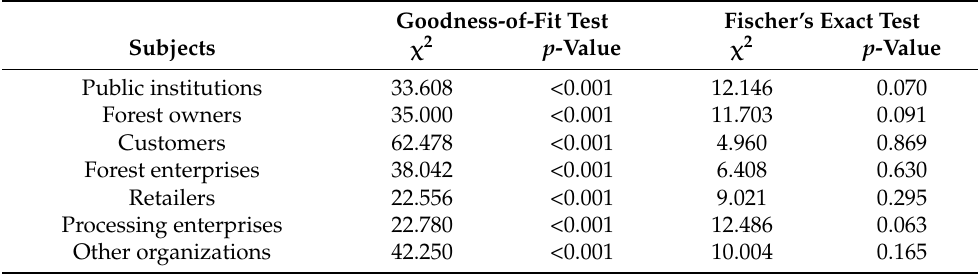
Table 5. Respondents’ perceptions of the effectiveness of their promotional activities with reference to the subjects to whom these were addressed. Goodness of fit test: Comparison of grouped responses from all respondents with expected uniform distributions of responses. Fischer’s exact test: Associations between organizations’ categories and reasons’ ratings. Significance set at a level of